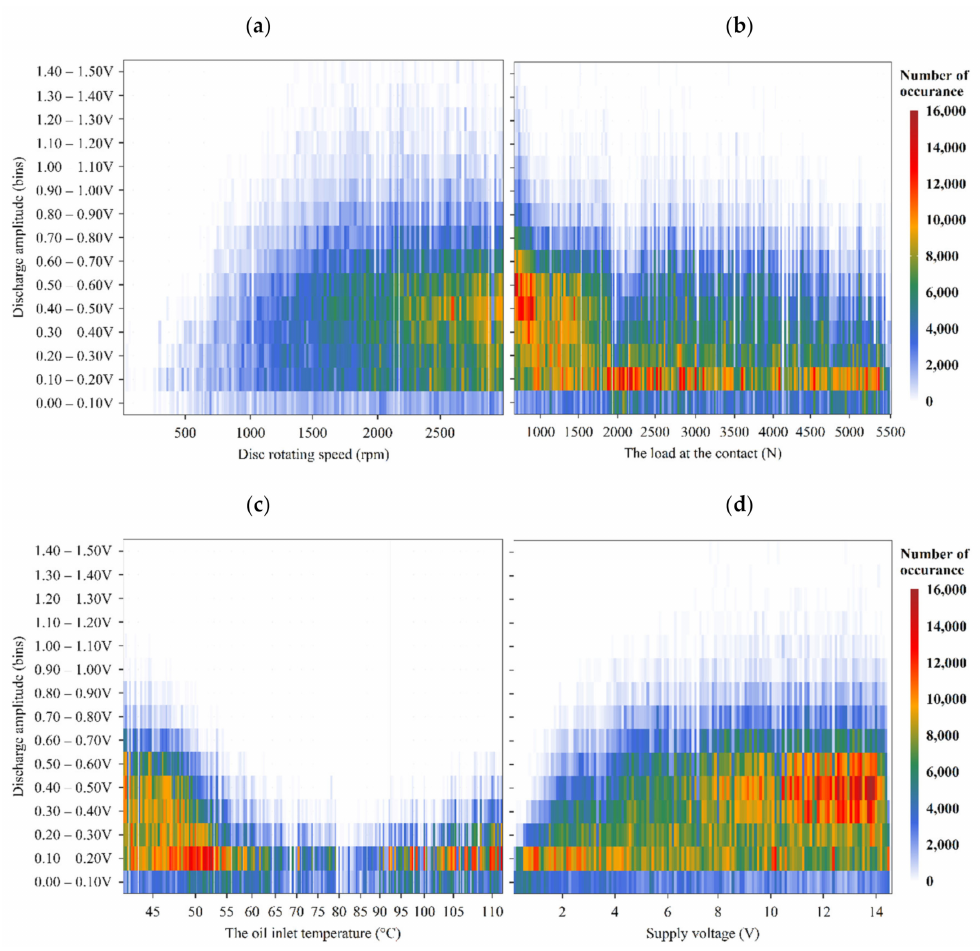
Figure 11. Color maps of the number of discharge events and their corresponding discharge ampli- tude (within defined bins) as a function of a change in test conditions; ( a ) disc rotating speed, ( b ) load applied to the discs’ contact, ( c ) lubricant inlet temperature, and ( d ) supply voltage under 3000 rpm, 1145 N and 40 ◦ C